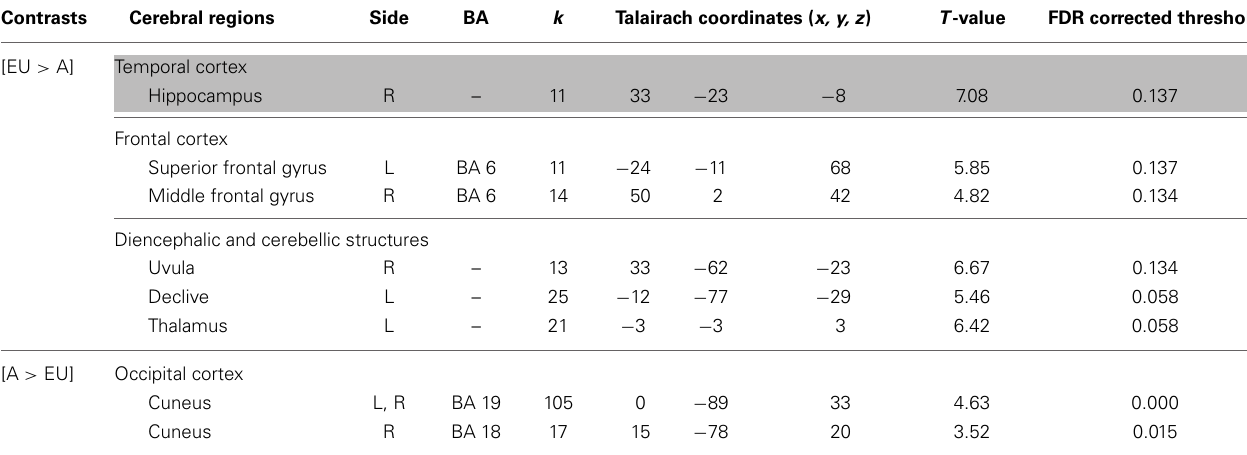
Table 3 | Activated regions due to self-related changes in location and orientation during spatial encoding, provided by the contrast: (1) EU vs. A for the upper part of the table; (2) A vs. EU for the lower part of the table (random-effect analysis, uncorrected p < 0 . 001, k ≥ 10